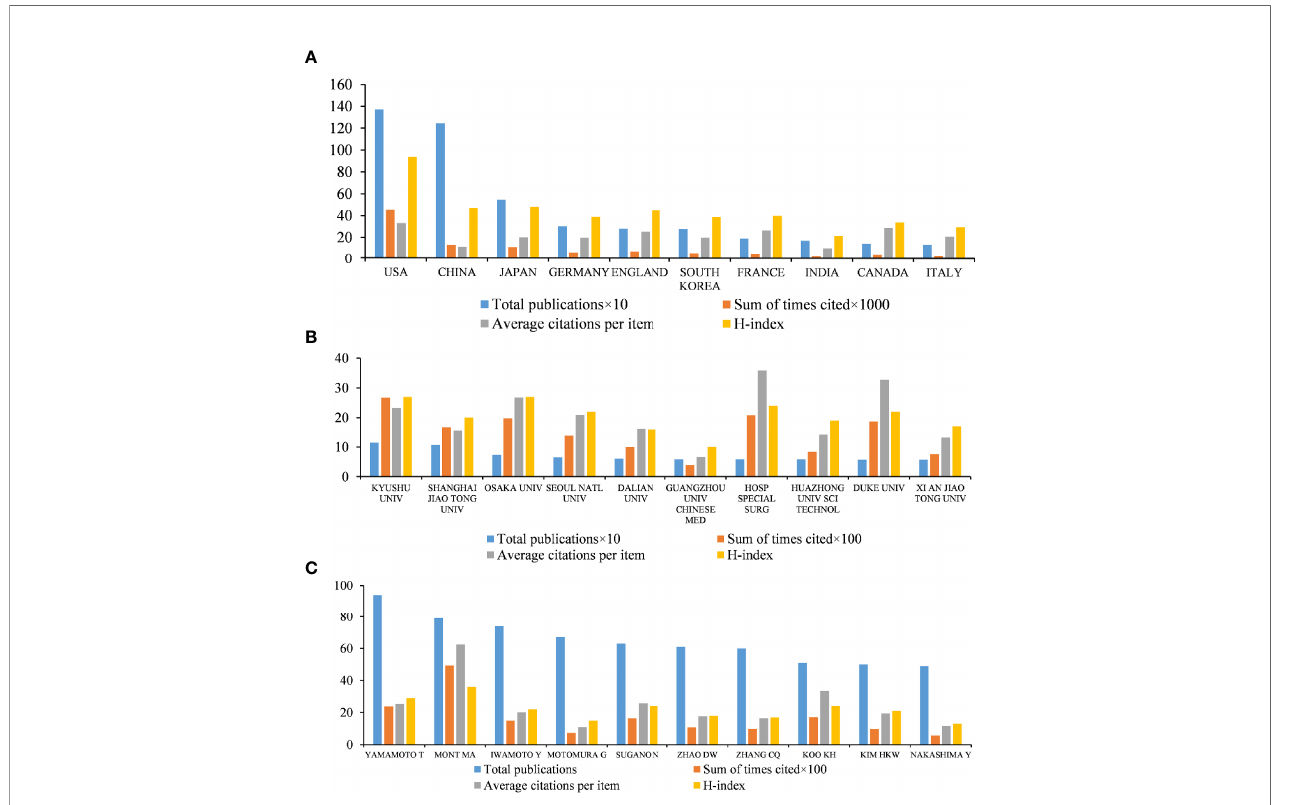
FIGURE 2 | Quality analysis of global publications in ONFH in the last 30 years. (A) Total publications, sum of times cited, average citations per item, and H-index of the top ten countries by contributions. (B) Total publications, sum of times cited, average citations per item, and H-index of the top ten institutions by contributions. (C) Total publications, sum of times cited, average citations per item, and H-index of the top ten authors by